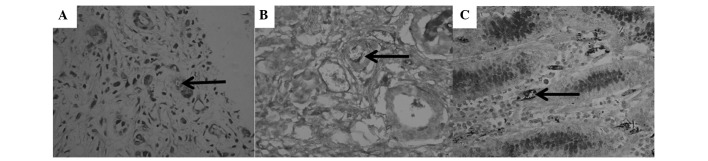
Expression of VM in GAC and gastritis tissues (magnification, ×400). (A) VM in GAC tissue (arrow, hematoxylin and eosin). (B) VM in GAC tissue (arrow, CD31/PAS). (C) VM-negative expression in gastritis tissue (arrow indicates typical blood vessel, CD31/PAS). VM, vasculogenic mimicry; GAC, gastric adenocarcinoma; CD, cluster of differentiation; PAS, periodic acid-Schiff.